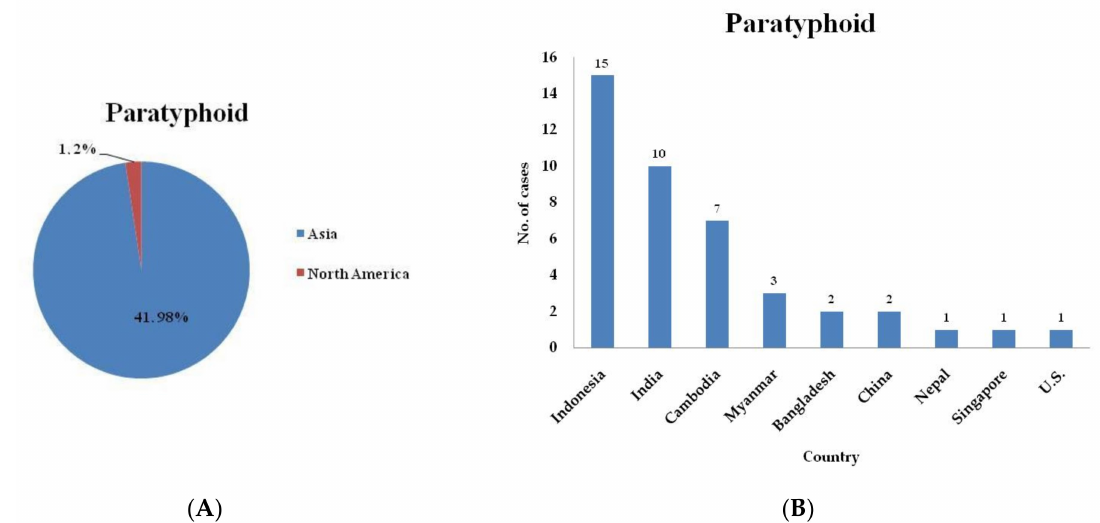
Figure 4. Paratyphoid cases reported in Taiwan arriving from Asian countries and other countries ( A ) and cases imported from Indonesia and other countries ( B ) from 2011 to 2020. Indonesia (in Asia) is the country in which the most typhoid cases imported into Taiwan